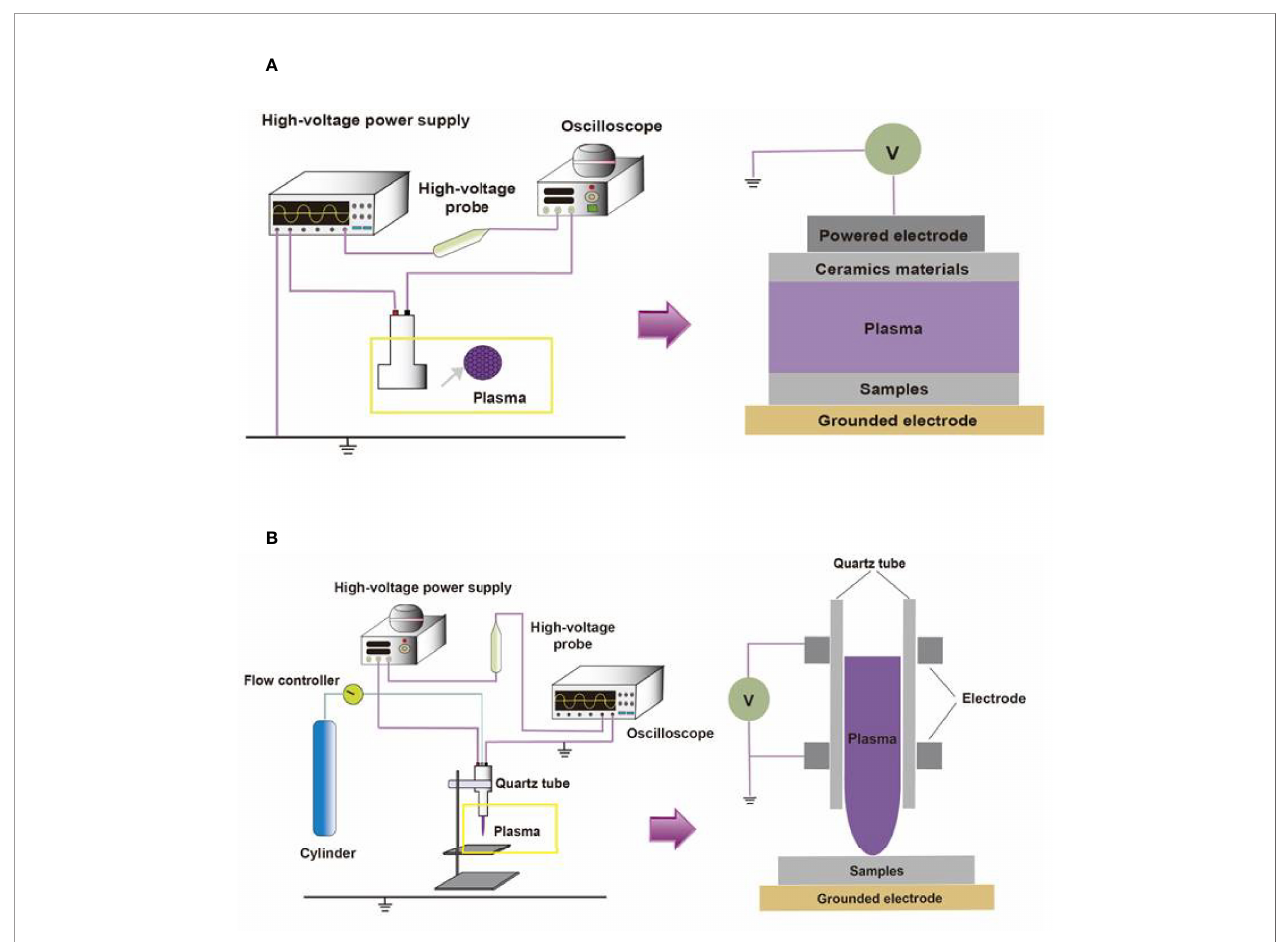
FIGURE 1 | The compositions of two different CAP platforms. (A) The surface barrier discharges or (B) the atmospheric pressure plasma jet consists of a high- voltage source, high-voltage probe, oscilloscope, quartz tube, cylinder, and fl ow